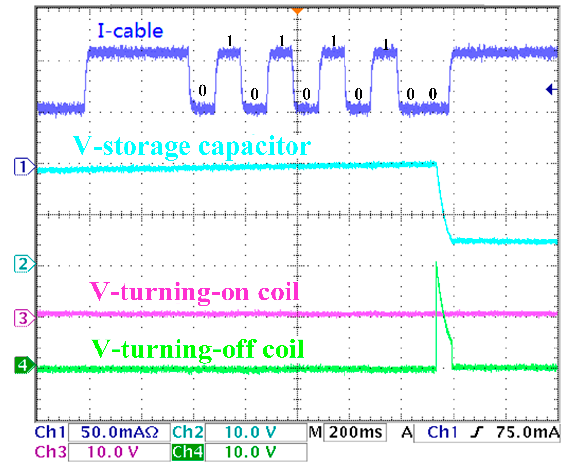
Figure 17. Turning-on command.